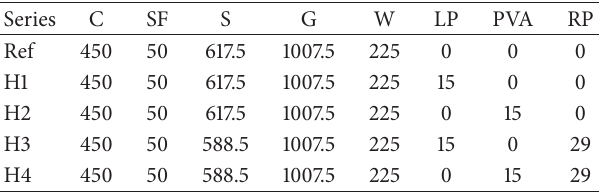
Table 2: Mix design of concrete (kg/m 3